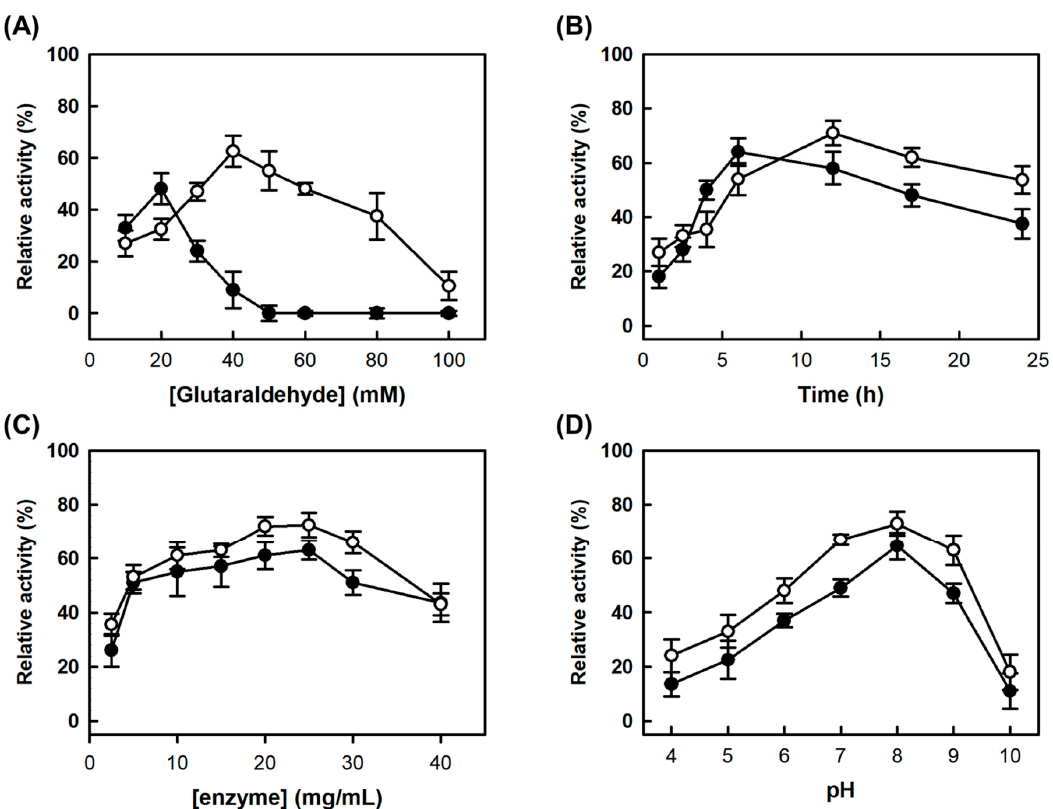
Figure 2. Optimization of cross-linking condition for cross-linked enzyme aggregates of the fused enzyme (CLEAs-MAPO) (closed circles) and combi-CLEAs (open circles). ( A ) Glutaraldehyde concentration; ( B ) cross-linking time; ( C ) protein concentration; ( D ) the CLEAs at each condition were recovered by centrifugation (12000 × g for 10 min), followed by washing and resuspension in 100 mM phosphate buffer (pH 7.0) for the assay. The activities of amine oxidases were measured according to the peroxidase-coupled assay [16] using tyramine as the substrate at the optimum condition of each enzyme.